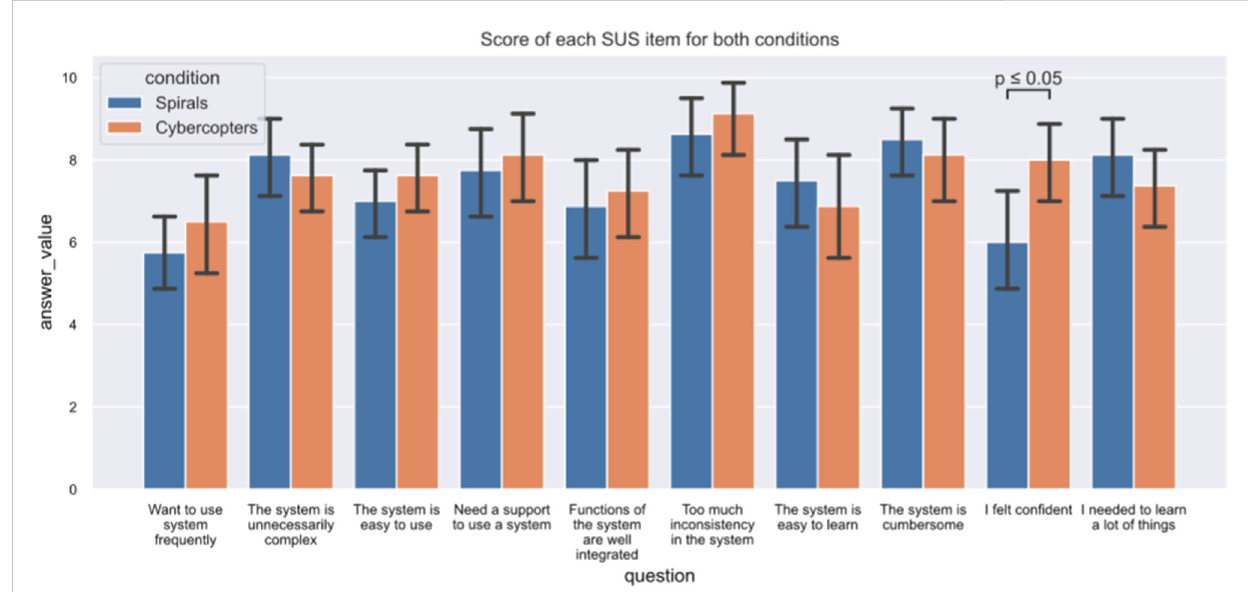
FIGURE 9 Detailedanswers totheSUSforbothinterfaces.The onlysigni fi cant difference between themrelatedto theninthquestion, gauging thecon fi dence of the participants.